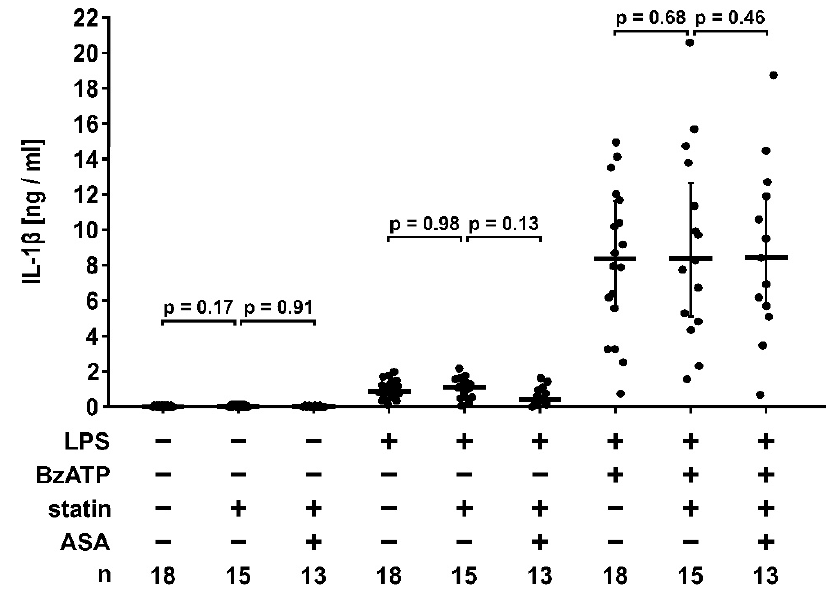
Figure 8. Release of interleukin-1 β (IL-1 β ) by monocytes isolated from the blood of patients suffering from low-grade coronary heart disease. Patient blood was drawn before lipid-lowering medication, after four weeks of statin intake and after another four weeks of combined treatment with statin and acetylsalicylic acid (ASA). IL-1 β was measured in cell culture supernatants of unstimulated cells, cells primed with lipopolysaccharide (LPS, 5 ng/mL, 3 h) or LPS-primed cells stimulated with 2 ′ (3 ′ )- O -(4-benzoylbenzoyl)adenosine 5 ′ -triphosphate (BzATP, 100 µM, 30 min). Data are presented as individual data points; bar represents median; whiskers encompass the 25th to 75th percentile. Experimental groups were compared by the Friedman test followed by the Wilcoxon signed-rank test.